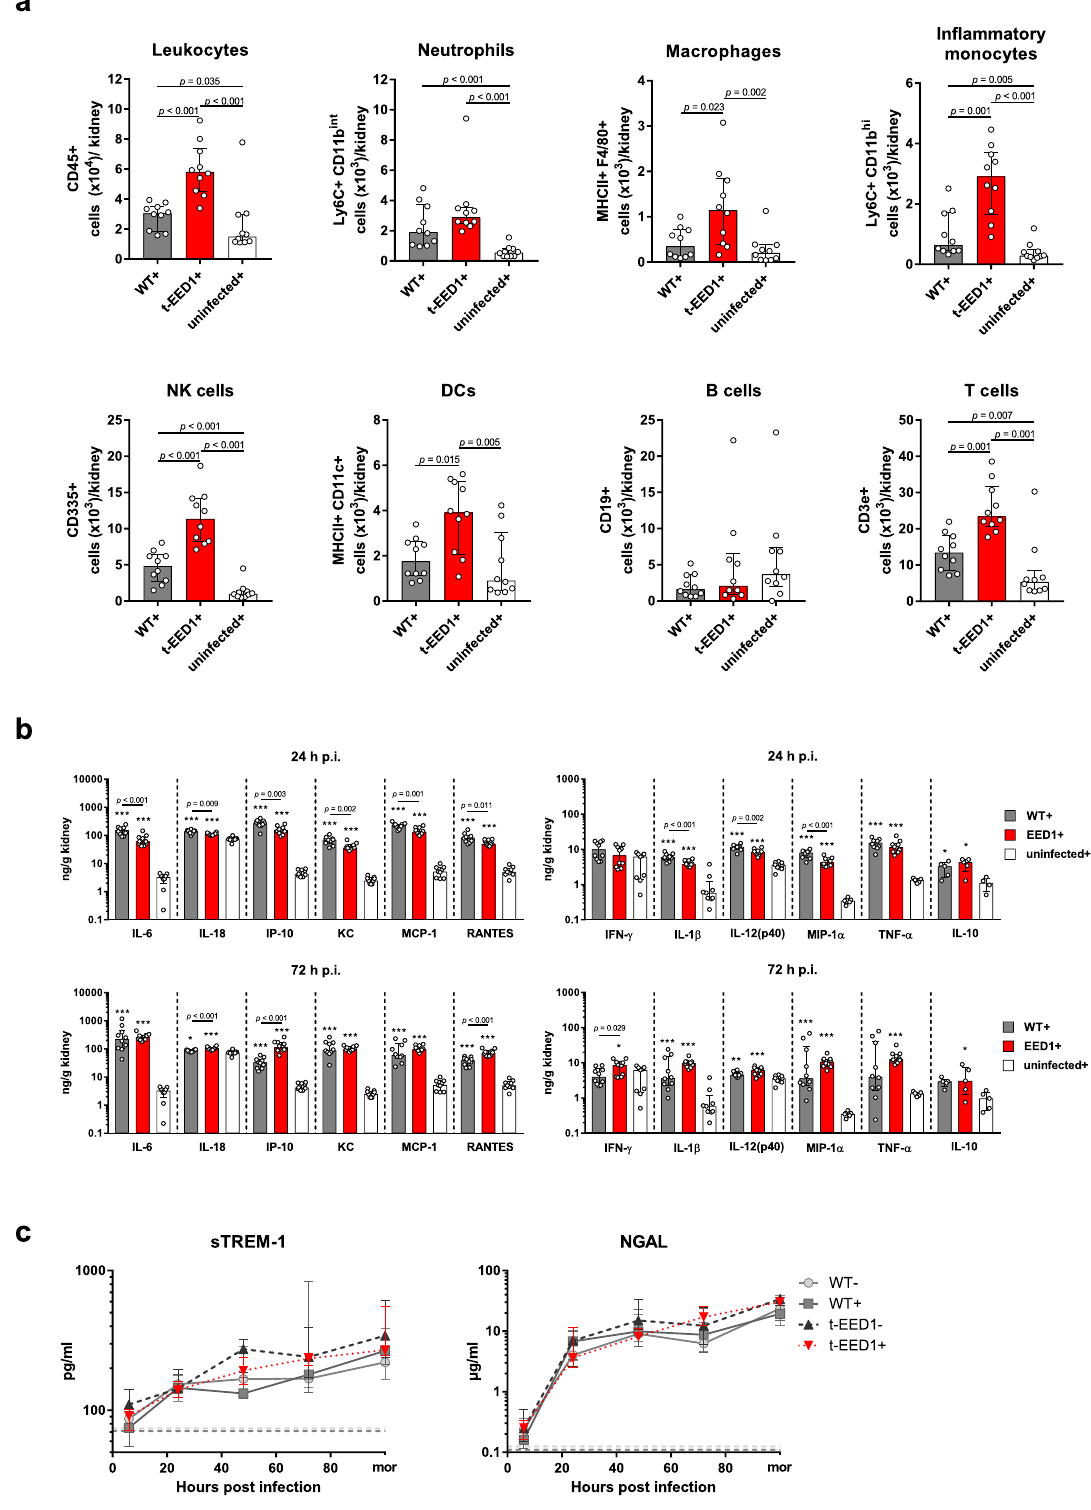
evaluated kidney function by measuring serum creatinine and blood urea nitrogen (BUN) levels. Both increased at comparable rates, reaching highly elevated levels indicating severe renal dysfunction 41,42 in moribund mice only (Fig. 8b, c). Finally, the same extent of apoptosis was observed in the kidneys of mor- ibund mice infected with either WT or t-EED1 (Fig. 8d, e). Therefore, enhanced fungal proliferation can compensate for the